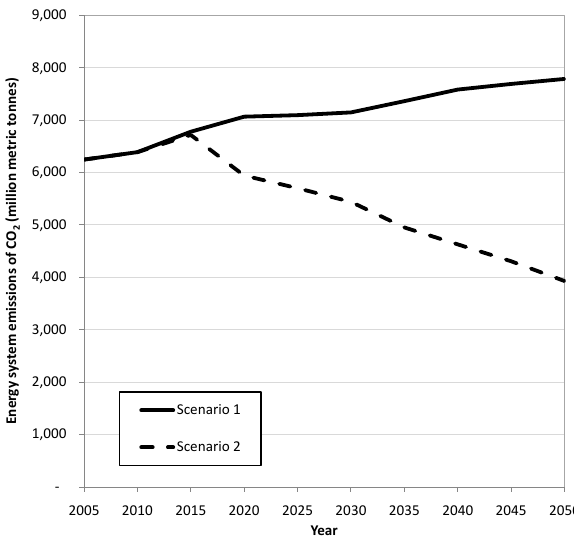
Fig. 2. Annual national emissions of CO 2 for Scenarios 1 and